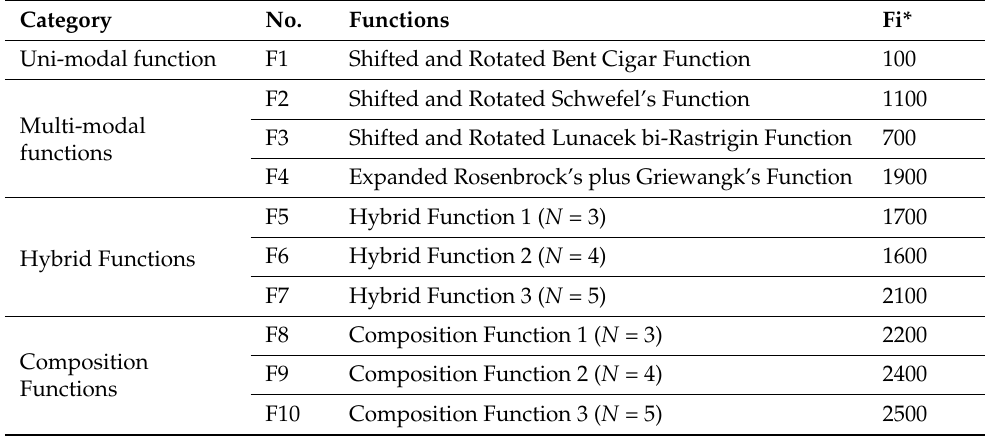
Table 1. CEC’2020 test suite description.